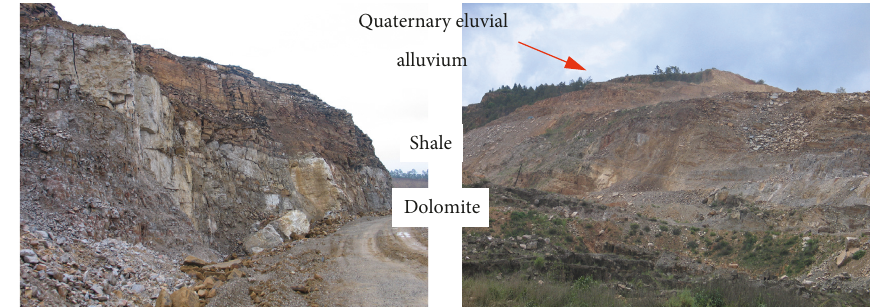
Figure 2: Bench of Baideng phosphorite.